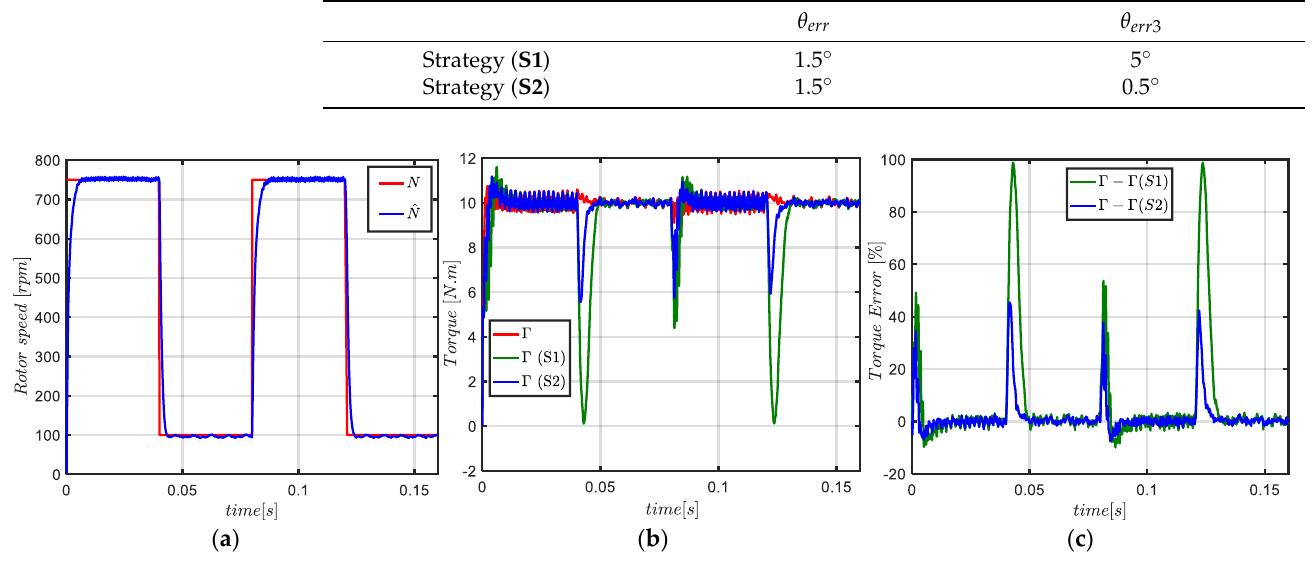
Figure 22. Simulation waveforms for variable rotor speed: ( a ) actual and estimated rotor speed, ( b ) torque when the five-phase PMSM is controlled by the encoder, sensorless control ( S1 ), and sensorless control ( S2 ), ( c ) torque